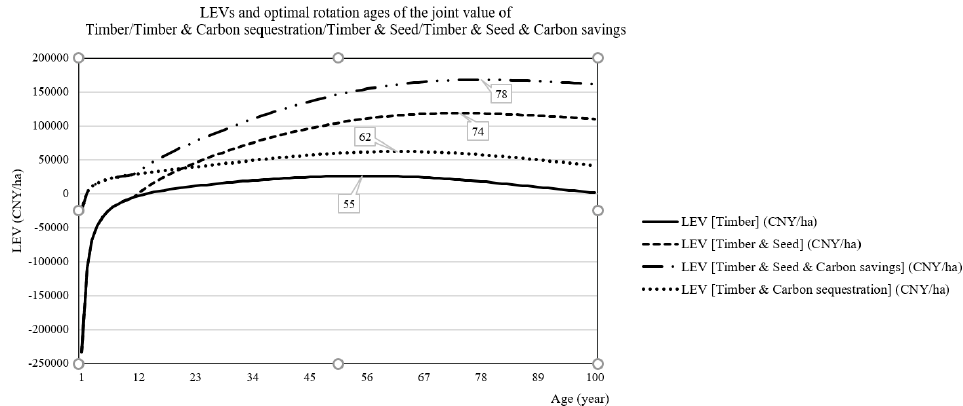
Figure 2. The LEVs and optimal rotation ages of the joint values of timber/timber and carbon sequestration/timber and seed/timber, seed and total carbon savings of Pistacia chinensis . (The numbers in the boxes indicate the optimal rotation age of each LEV.). in the boxes indicate the optimal rotation age of each